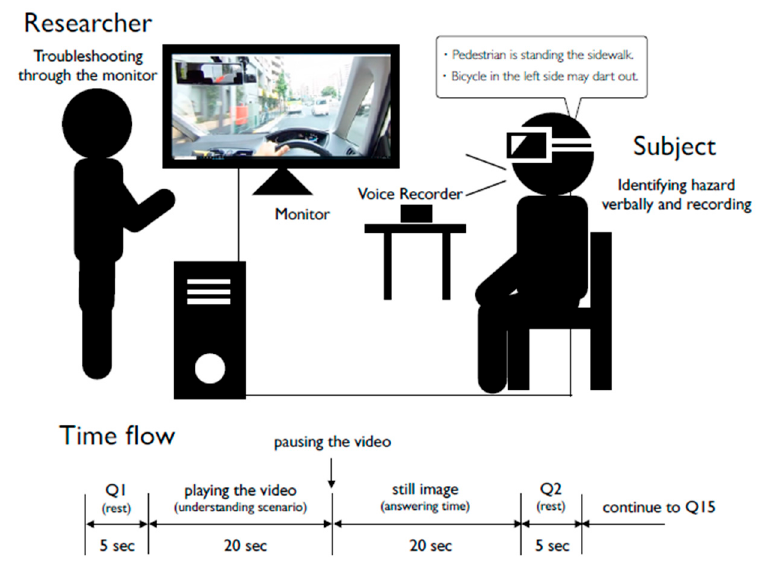
Figure 2. Experimental procedure.